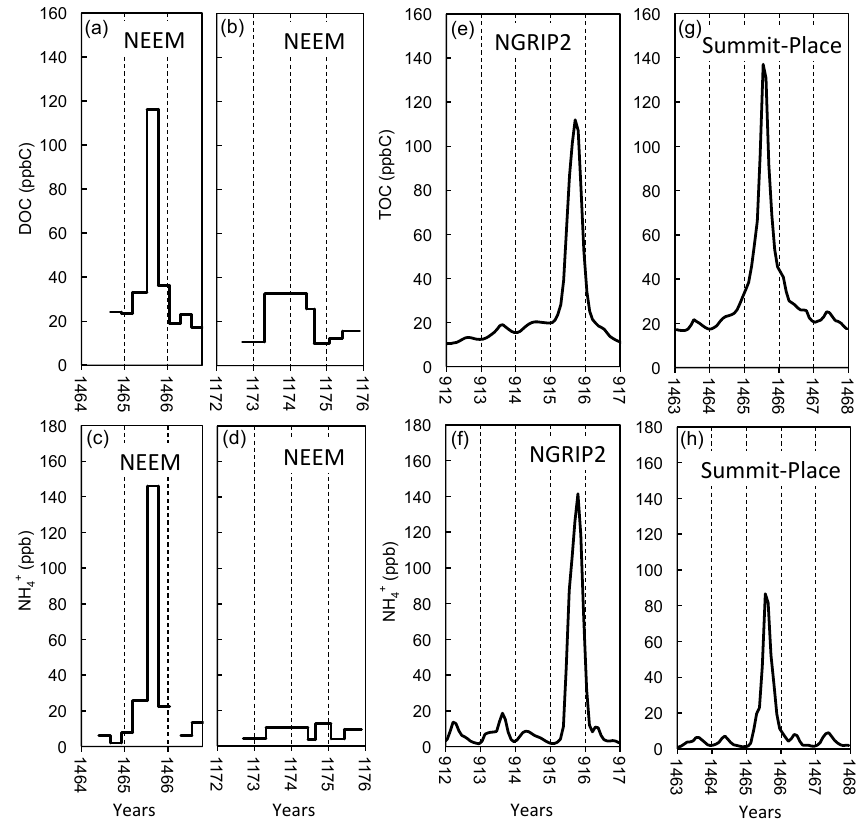
Figure 8. Example of OC changes along fire events in Greenland ice. Panels (a) to (d) are from the NEEM-2011-S1 ice core for which OC was measured with a UV oxidation method (Sect. 2) and ammonium on discrete samples analyzed with ion chromatography. Panels (e) to (h) are from North GRIP2 and Summit-Place (collected in 2015) ice for which ammonium was measured with a CFA system and OC was investigated with a CFA coupled to a total organic carbon analyzer (Sect. 2). The NEEM-2011-S1 and North GRIP2 cores were drilled with organic drilling fluid and the Summit-2015-Place core